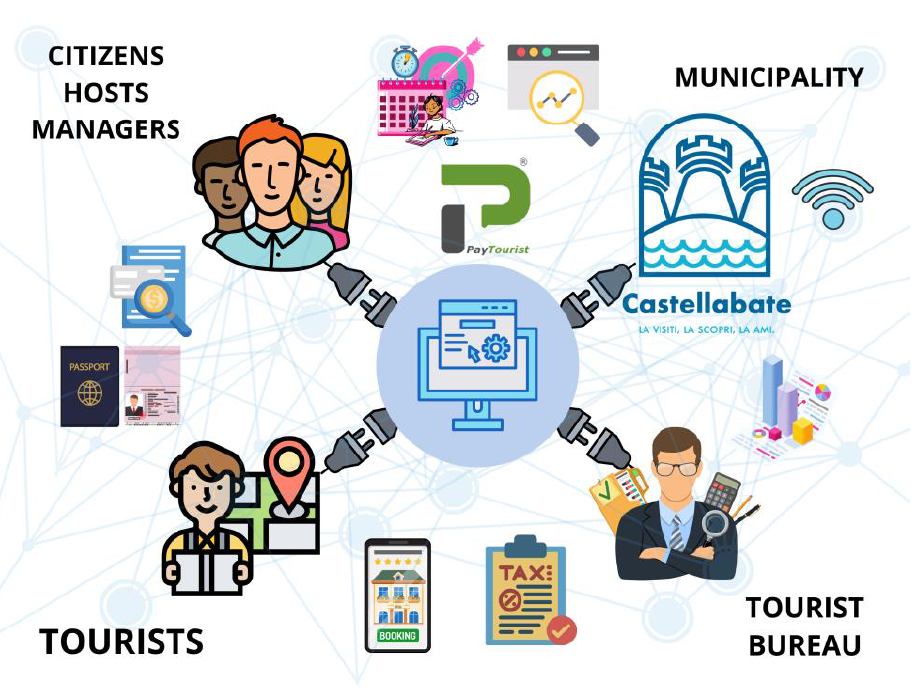
Fig. 1. The multi-layered setup of smart urban ecosystem augmented by